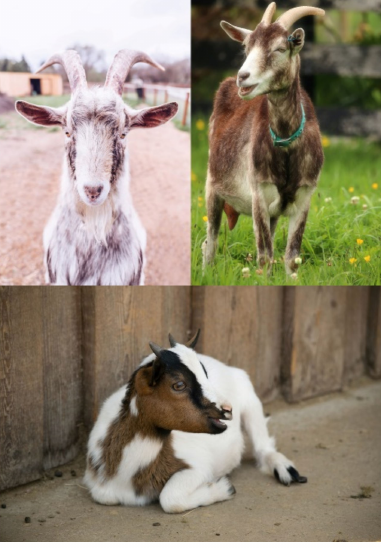
Figure 1. Adult animals (upper panels) and goat (lower panel) of the species Capra aegagrus